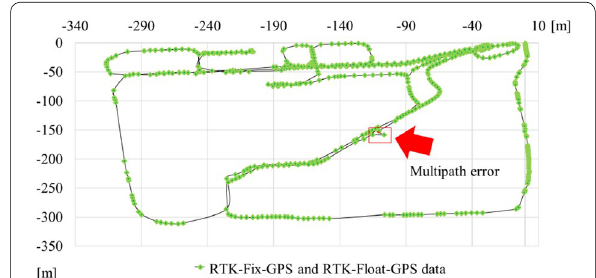
Fig. 16 RTK-Fix-GPS and RTK-Float-GPS data (green) and estimated RTK-Fix-GPS and RTK-Float-GPS trajectory (black line) with multipath error (red arrow)